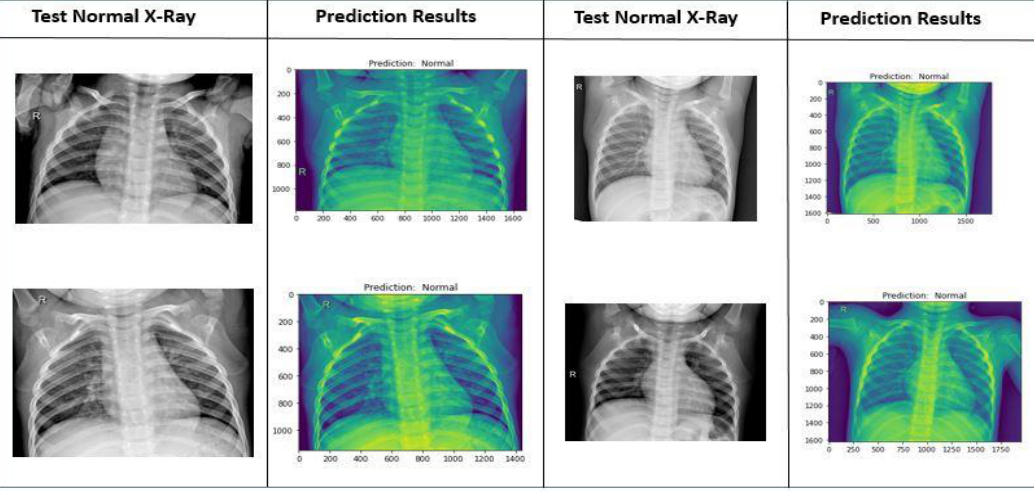
Figure 12. Normal X-rays and outputs produced by the model.